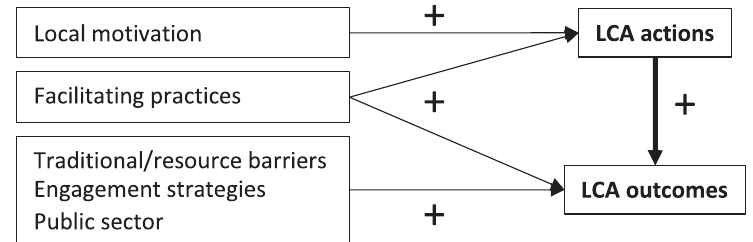
Figure 1. Summary of main findings. Note: + denotes a positive